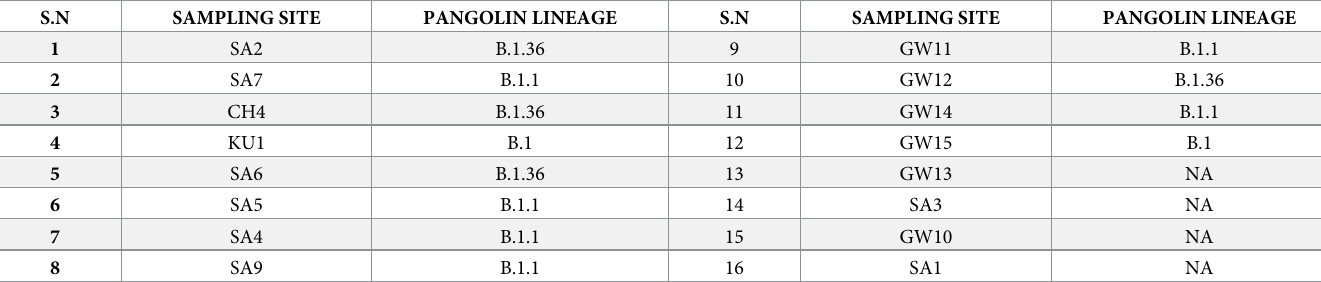
Table 3. SARS-CoV-2 Pangolin lineages of consensus sequence generated from the environmental samples from CovGlue submission.